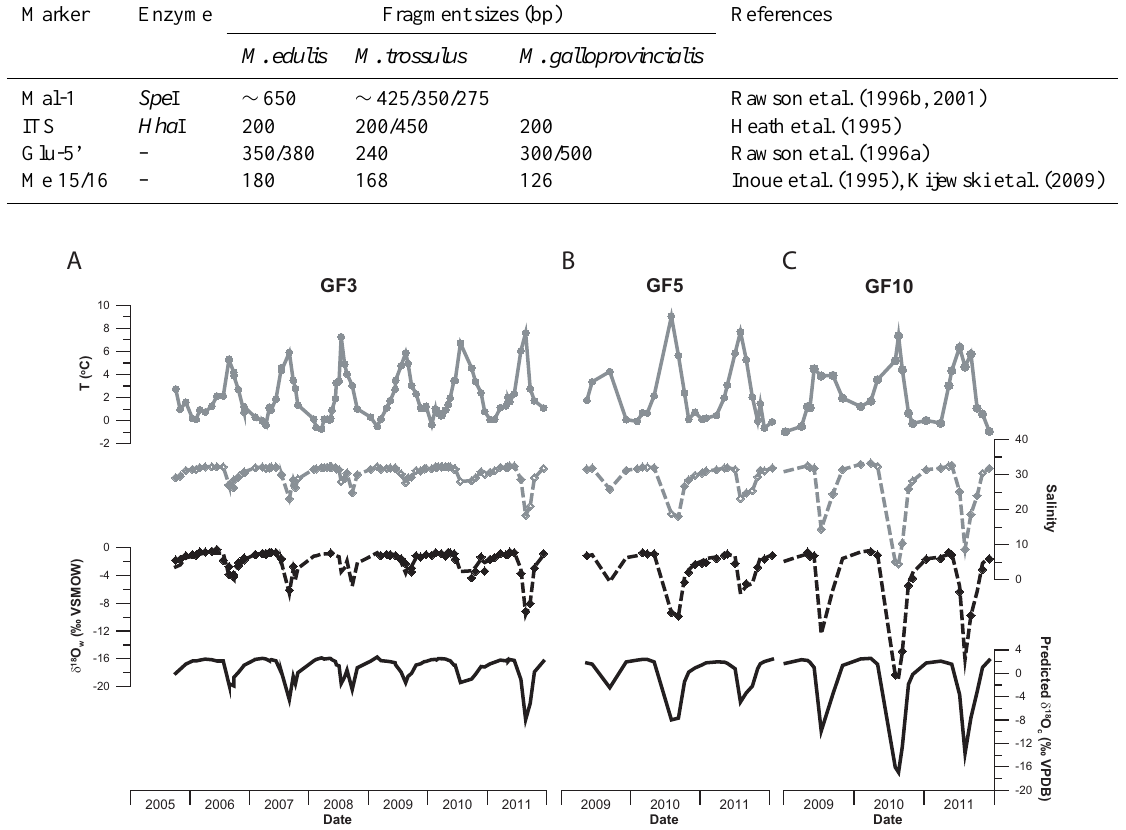
Fig. 2. Environmental data at water monitoring locations. Solid grey circles and lines are temperature; grey diamonds and dashed lines are salinity. Black diamonds are measured δ 18 O w values; dashed black lines show δ 18 O w values calculated from the linear relationship between salinity and δ 18 O w values (Eq. 4). Solid black lines indicate δ 18 O pred values based on temperature and δ 18 O w values, calculated according to Eq.